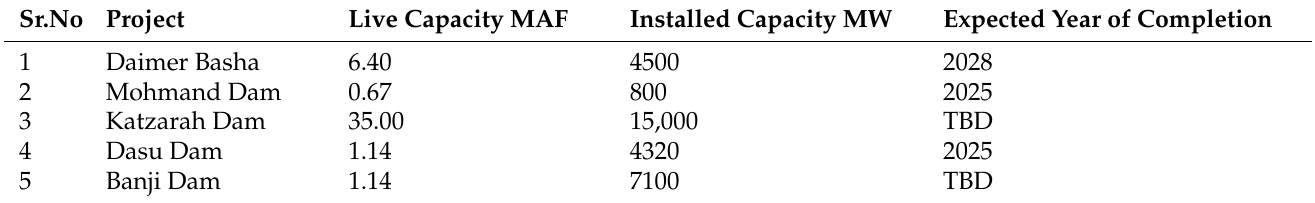
Figure 3. The Indus Basin of Pakistan [52]. Figure 1. Schematic diagram of the Indus River Basin (IRB) showing its major rivers and tributaries with the locations of the existing and proposed reservoirs and barrages. The reservoirs Table 2. Proposed future projects and barrages on the Indus and Jhelum Rivers were analyzed in the study.